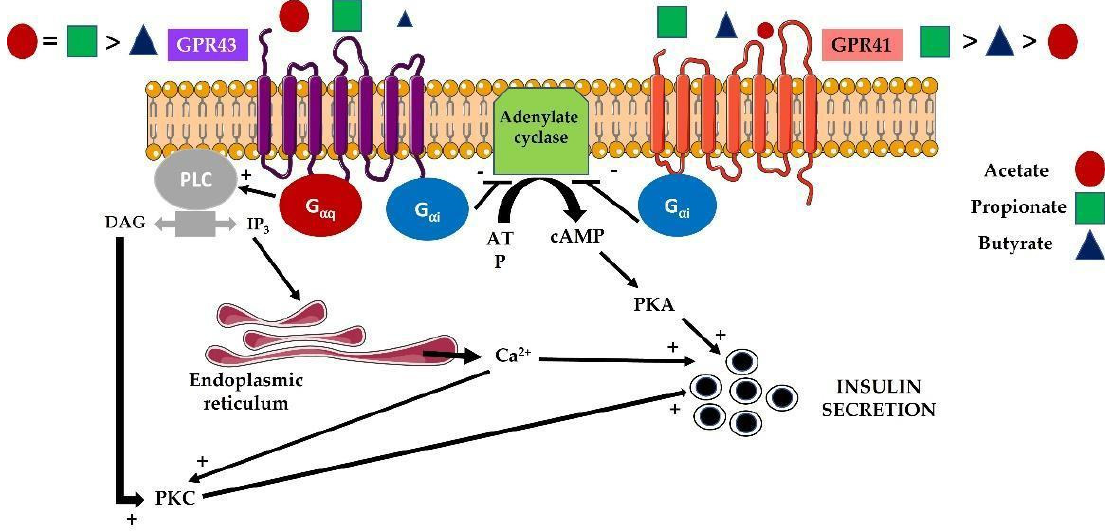
Figure 2. Effect of the different SCFAs on the different receptors in pancreatic beta cells regulating insulin secretion. Both GPR43 and GPR41 are GPCRs acting through two alternative pathways; G α q and with the concomitant activation of phospholipase C (PLC) with the hydrolysis of PIP2 into diacylglycerol (DAG) and inositol triphosphate (IP3). DAG is able to activate protein kinase C (PKC) and IP3 goes to the endoplasmic reticulum to stimulate IP3 receptors and permit Ca 2+ exit to the